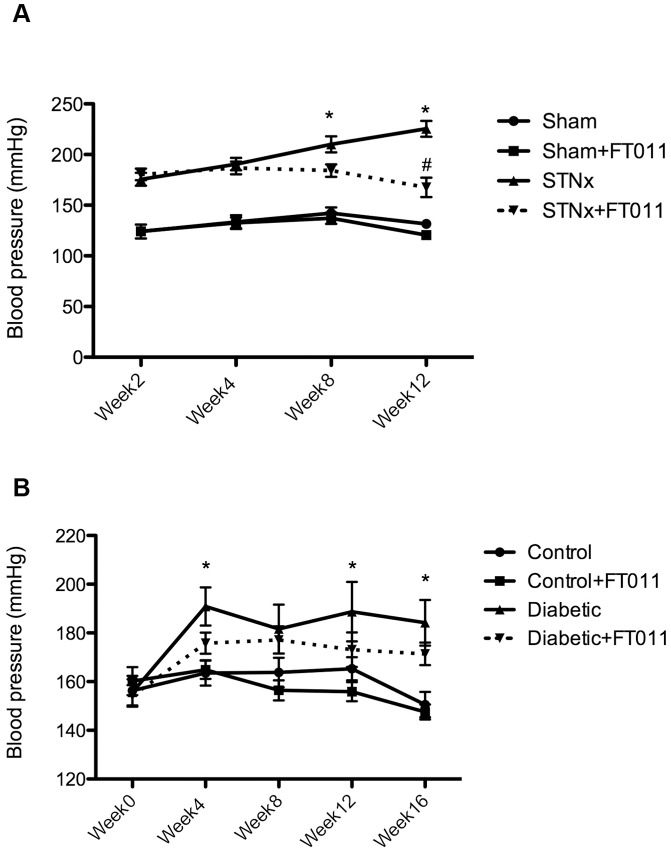
Systolic blood pressure in STNx and diabetic rats.Systolic blood pressure in STNx and diabetic rats was progressively elevated during the course of the study (Figure 2A and Figure 2B) when compared to sham and control rats, respectively. Treatment of STNx rats with FT011 prevented elevation in blood pressure (Figure 2A), while FT011 did not affect blood pressure in diabetic Ren-2 rats through the course of the study (Figure 2B). Data are expressed as mean ± SEM. *P<0.01 compared with sham or control, #P<0.05 versus untreated STNx rats.